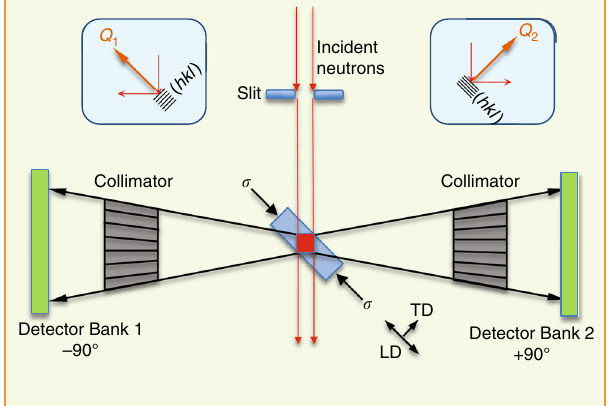
Fig. 1 Schematic of in situ neutron diffraction experimental set-up on VULCAN. Top down view, not to scale. The red square represents the sampling volume de fi ned by the incident beam and the radial collimators. The − 90° and + 90° detector banks record diffractions from the grains whose lattice planes ( hkl ) are perpendicular to Q 1 and Q 2 , respectively, as shown in the two insets. The compression specimen (light-blue rectangle) is positioned at 45° from the incident beam such that Bank 1 probes the strain component along the loading direction (LD) while Bank 2 simultaneously detects the strain component in the transverse direction